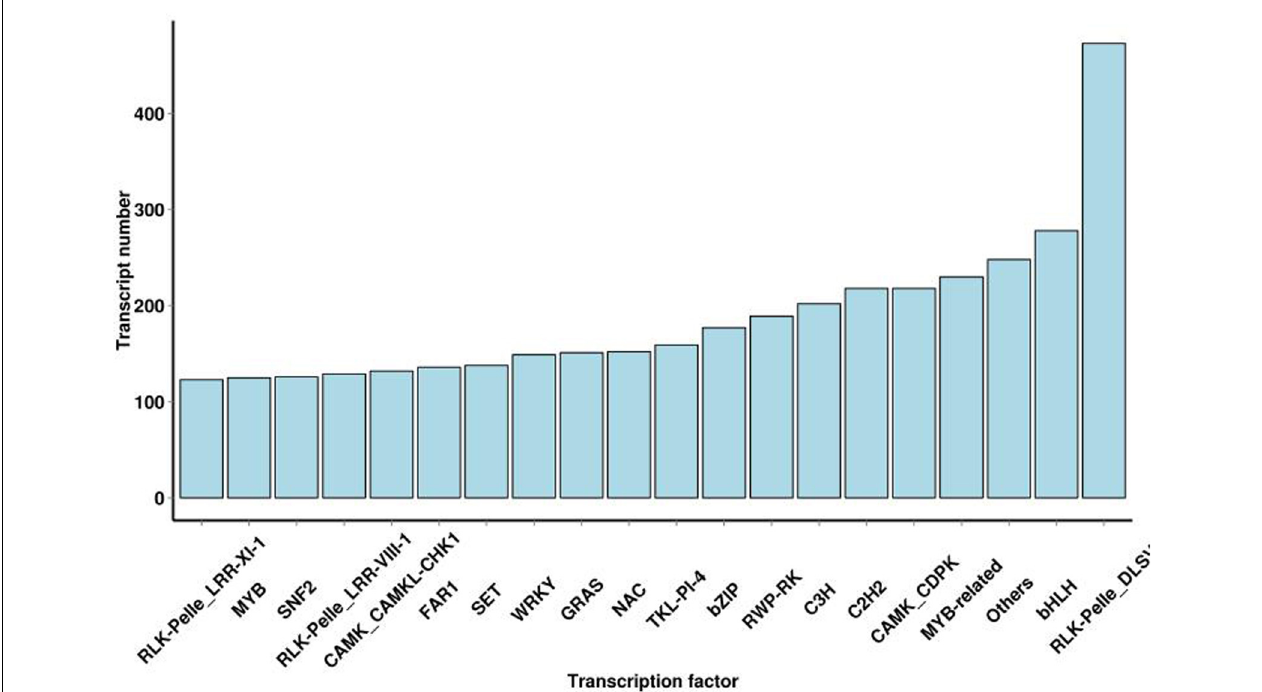
FIGURE 4 | Distribution of transcription factor